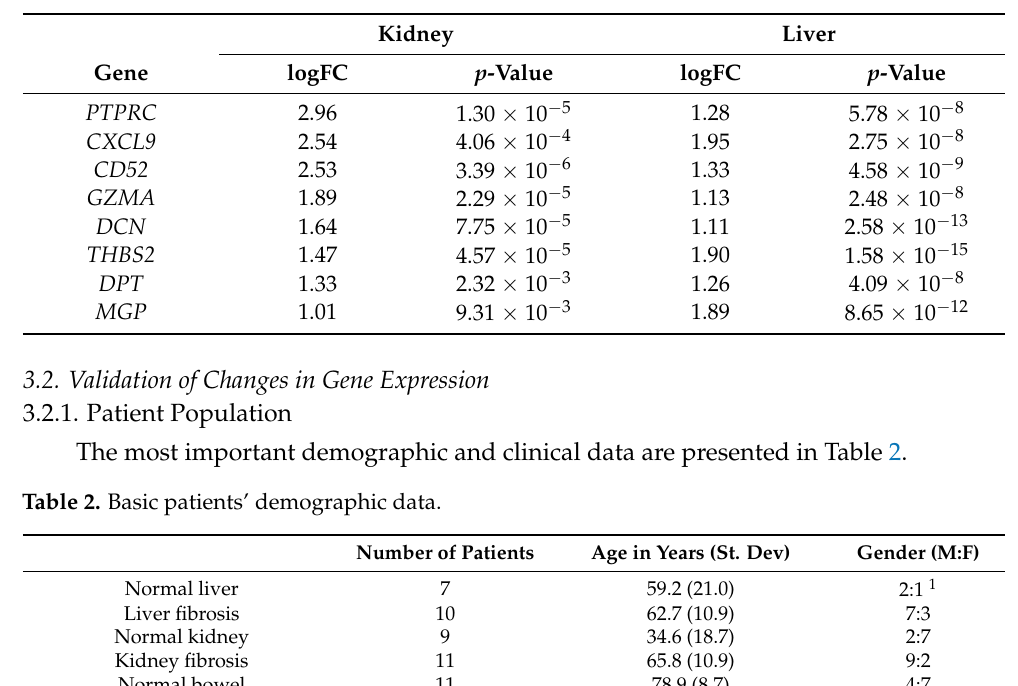
Table 1. Differences in expression of six chosen genes between normal and fibrotic tissue expressed as fold change in kidney and liver tissue. Legend: logFC, logarithm of fold change.